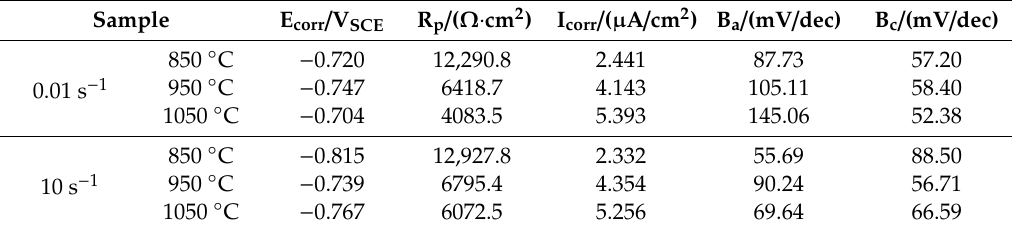
Table 2. Electrochemical test results of 35CrMoV steel.